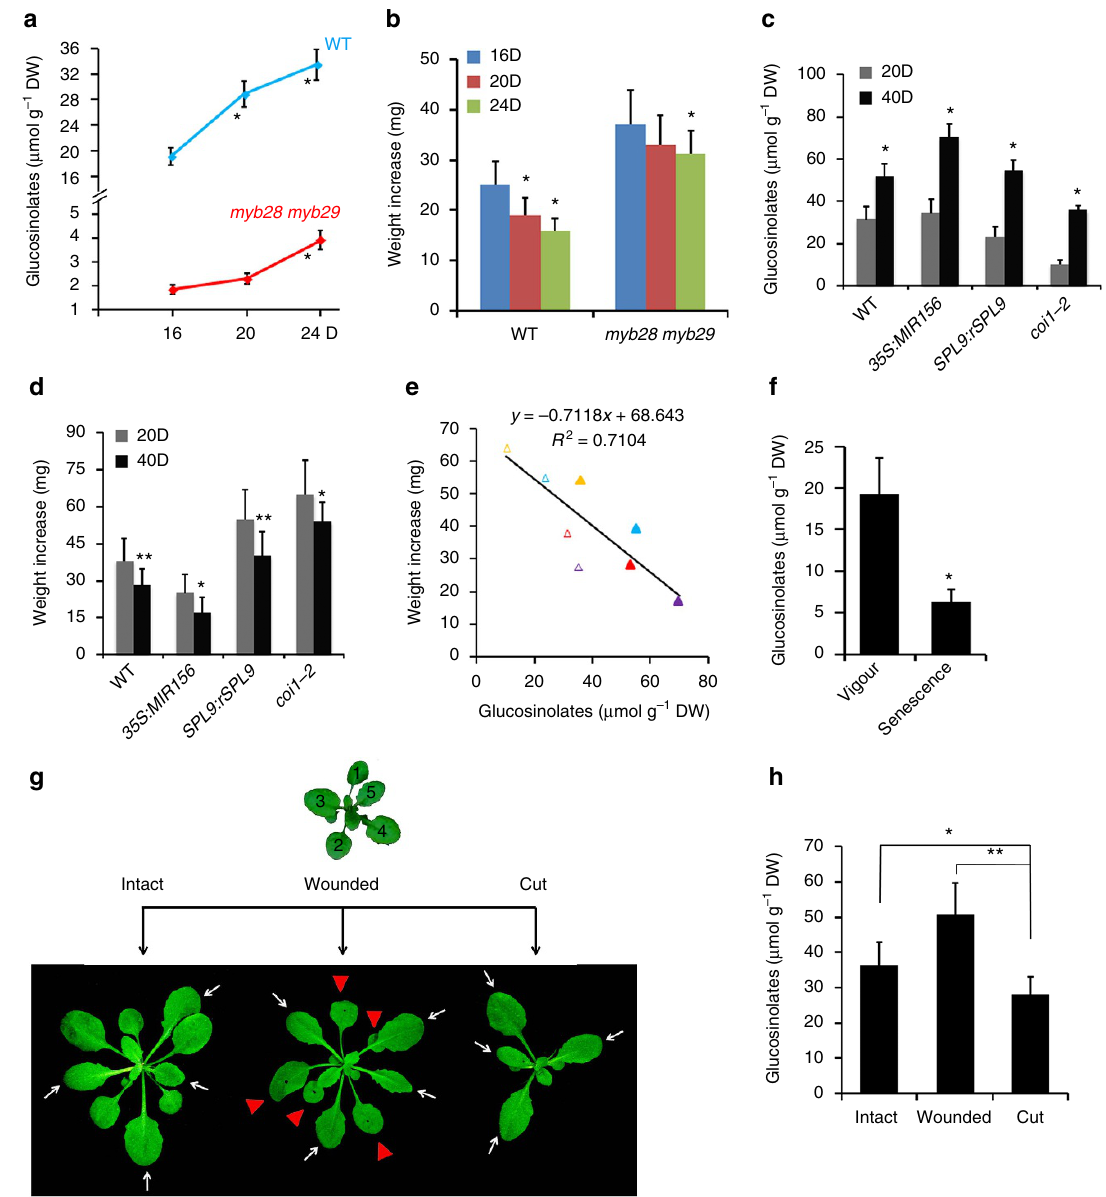
Figure 7 | Increased accumulation of GLSs in old plant enhances insect resistance. GLSs content was detected by LC-MS ( a , c , f , h ). Error bars represent ± s.d. ( n ¼ 3). ( a ) GLSs content in the wild-type (Col-0) and myb28 myb29 . Rapidly expanding leaves of 16-, 20- and 24-day-old plants in LD were used. Asterisk indicates significant difference from the 16-day-old plant (Student’s t -test, * P o 0.05). ( b ) Weight increase of H. armigera larvae fed with leaves described in a . Error bars represent ± s.d. ( n ¼ 25), asterisk indicates significant difference from the 16D group (Student’s t -test, * P o 0.05). ( c ) GLSs content in rapidly expanding leaves of 20- (20D) or 40-day-old (40D) plants of different genotypes in SD. Asterisk indicates significant difference from the 20D group (Student’s t -test, * P o 0.05). ( d ) Weight increase of H. armigera larvae fed with leaves described in c . Error bars represent ± s.d. ( n ¼ 25), asterisk indicates significant difference from the 20D group (Student’s t -test, * P o 0.05, ** P o 0.01). ( e ) Negative relation between GLSs content and larval growth. X axis represents GLSs content in the plant leaves as in c and y axis indicates larval weight increase in d . Weight increase of H. armigera larvae fed with leaves of 20-day-old plant in SD of the wild type (WT), 35S::MIR156 , SPL9::rSPL9 and coi1-2 shown as red, purple, blue and yellow hollow triangles, respectively, and those with 40-day-old plant leaves as the respective solid triangles. ( f ) GLSs decline in leaves during senescence. The first two leaves at vigorous stage (Vigour) from the 14-day-old plants or at senescent (Senescence) stage from the 28-day-old plants in LD were used. Asterisk indicates significant difference from vigour stage (Student’s t -test, * P o 0.05). ( g , h ) Possible mobilization of GLSs from the early leaves to new leaves. The first to fifth leaves from the 20-day-old plant in LD were removed or wounded, four days later the rest four leaves from the plant (cut), the same set of leaves from wounded plants (wounded) and the intact plant (intact) ( g ) were harvested for GLSs detection ( h ). White arrows indicate leaves collected for analysis and red triangles refer to wounded leaves. Asterisk indicates significant difference (Student’s t -test, * P o 0.05, ** P o